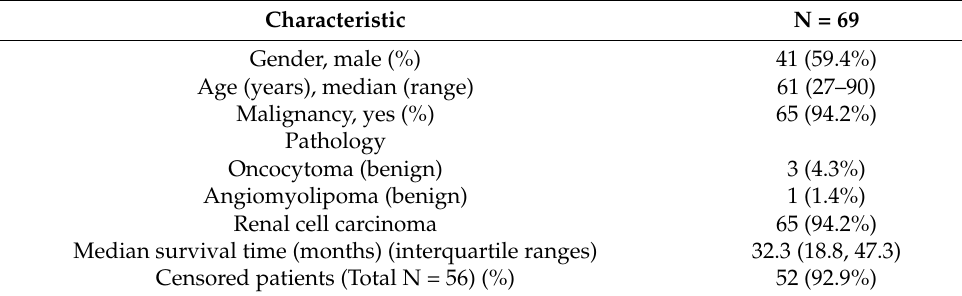
Table 2. Patient